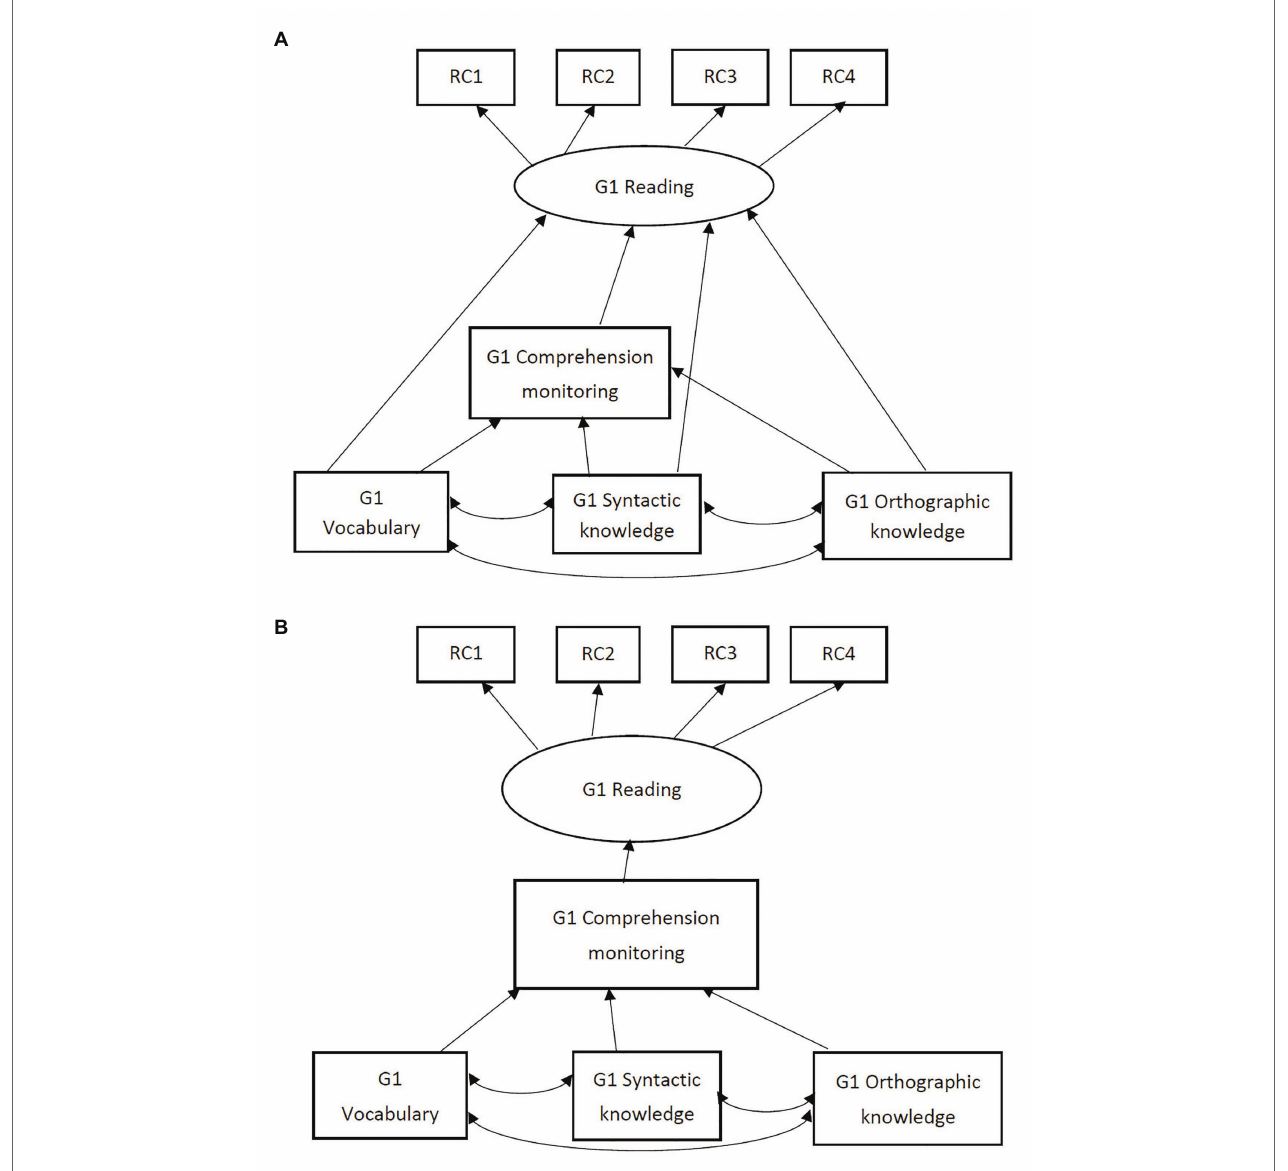
FIGURE 1 | Two alternative models of concurrent relations among Grade 1 reading, comprehension monitoring, and language skills. (A) Partial mediation model; (B) complete mediation model. GI = Grade 1; RC 1/2/3/4 = Reading comprehension task 1/2/3/4 in Grade